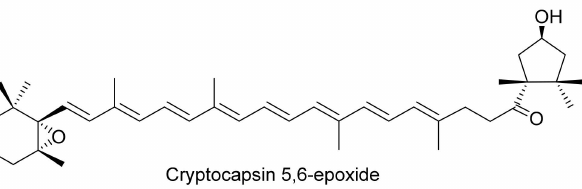
Figure 6. Structure of naturally occurring cryptocapsin 5,6-epoxide with a non-hydroxylated (5 R ,6 S )-5,6-epoxy β -end group.